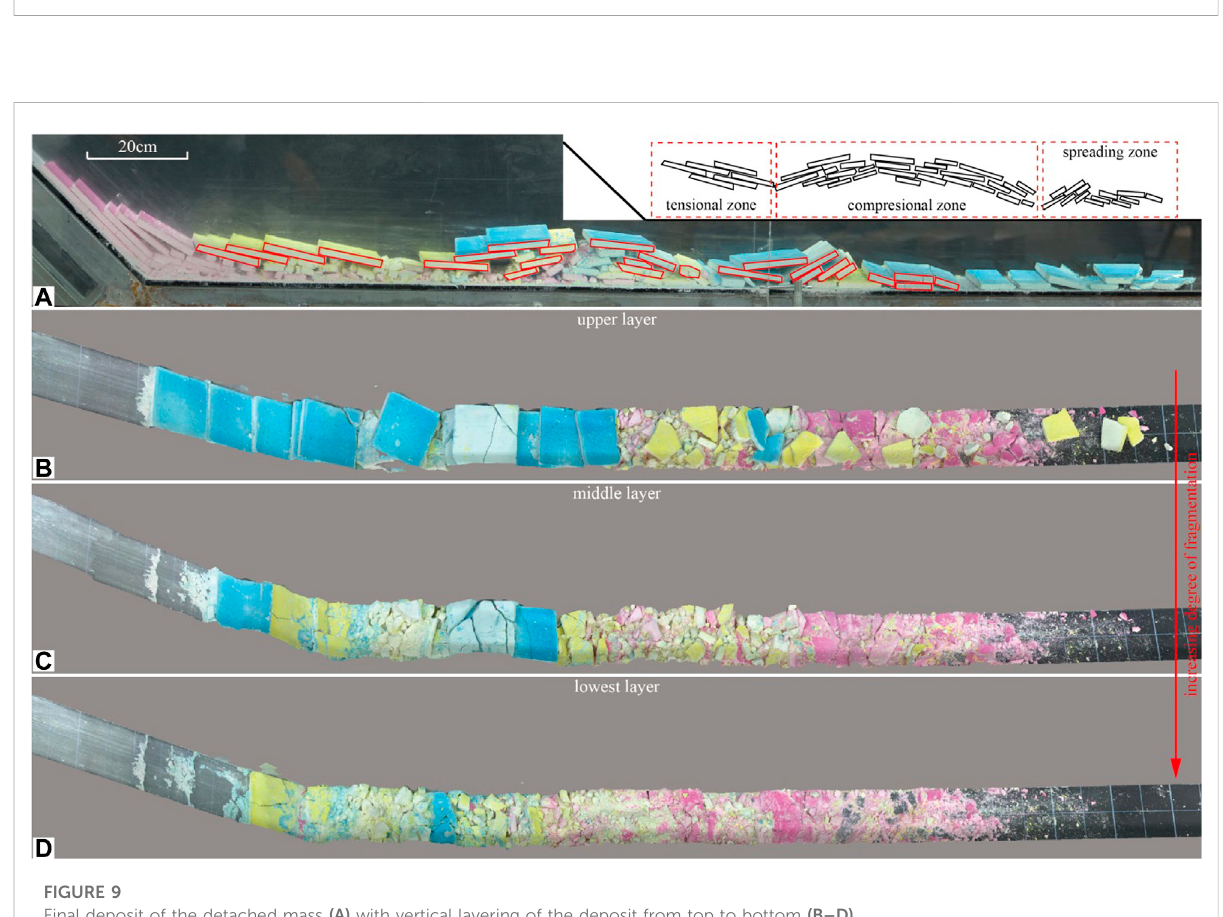
FIGURE 9 Final deposit of the detached mass (A) with vertical layering of the deposit from top to bottom (B – D)